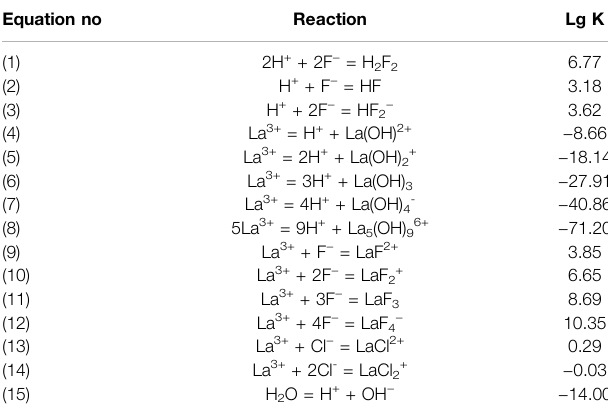
TABLE 1 | Chemical reactions in La-F-Cl-H 2 O aqueous system and their equilibrium constants. Equation no